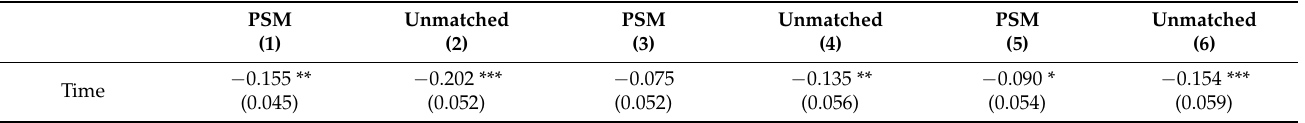
Table 3. Results of ordinal logistic regression